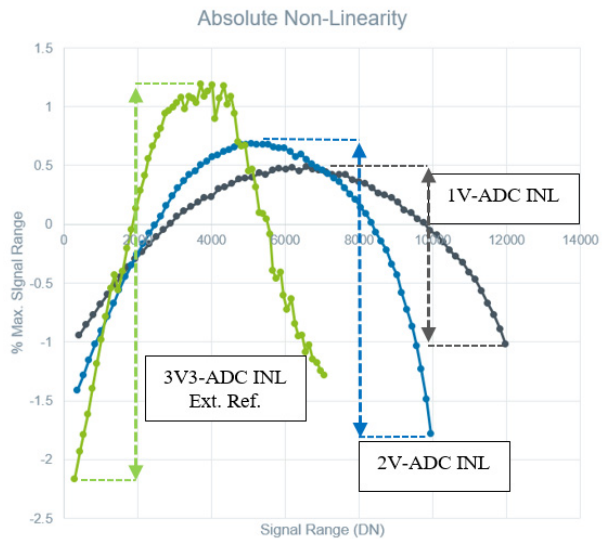
Figure 9. Absolute non-linearity curves.